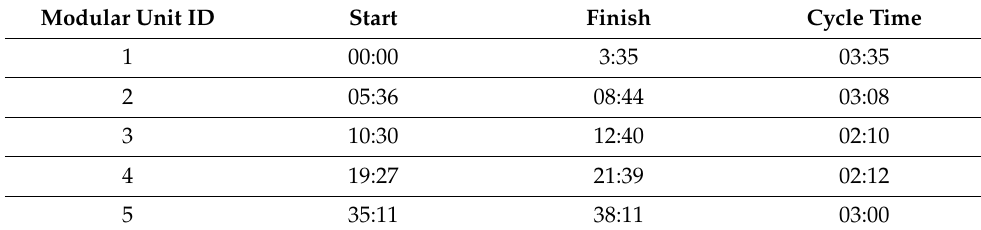
Table 3. Cycle times at workstation three. Times are in [hh:mm] format.